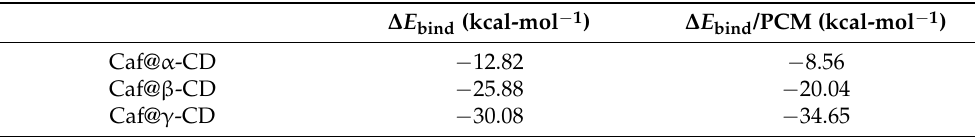
Table 3. Complexation energies of Caf@CDs calculated using the B3LYP-D3 DFT method, including the PCM water solvation